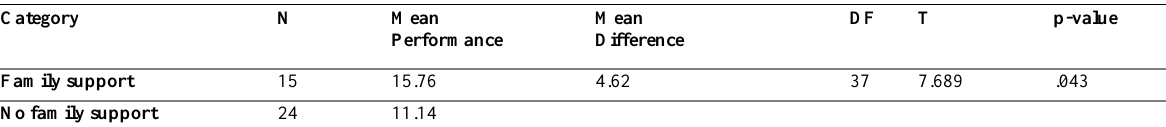
Table 4.19: Association between Family Support and